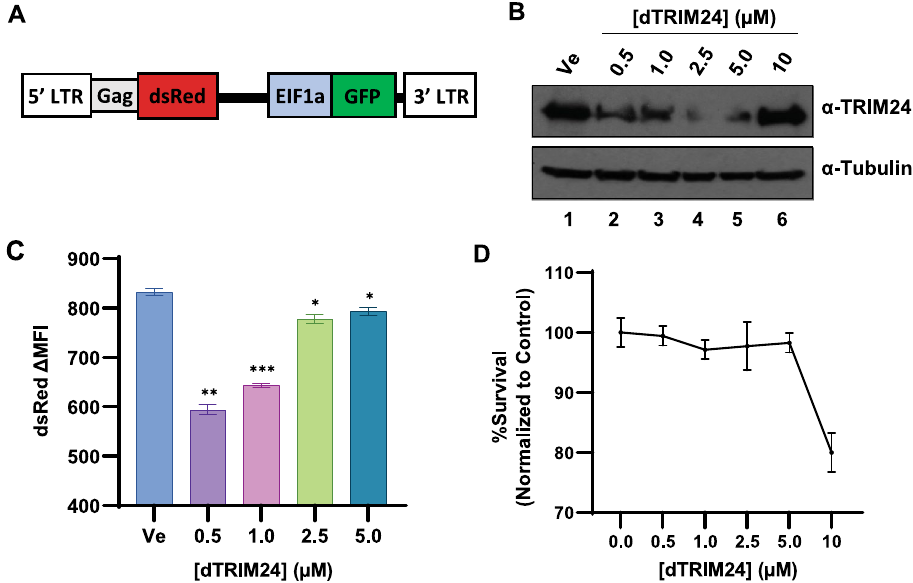
Figure 5. Effect of dTRIM24 on HIV-1 expression. ( A ) Schematic representation of HIV-1 mini-virus integrated in the Clone #11 Jurkat Tat cell line, where dsRed is expressed from the 5’ LTR, while GFP is driven by the constitutive EIF1α promoter 13 . ( B ) Clone #11 cells were treated with the indicated concentration of dTRIM24 or left untreated (Ve) for 24 h. Immunoblots were performed on whole cell lysates, with antibodies against TRIM24 (top) or Tubulin (bottom). ( C ) Following 4 h pre-treatment with the indicated concentration of dTRIM24, Clone #11 cells were stimulated with 40 nM PMA for 20 h and analyzed by flow cytometry. Assays were performed in duplicate, with error bars representing standard deviation. ( D ) Cell viability was measured in cells as treated in ( C ). Results are an average of two determinations, and error bars represent standard